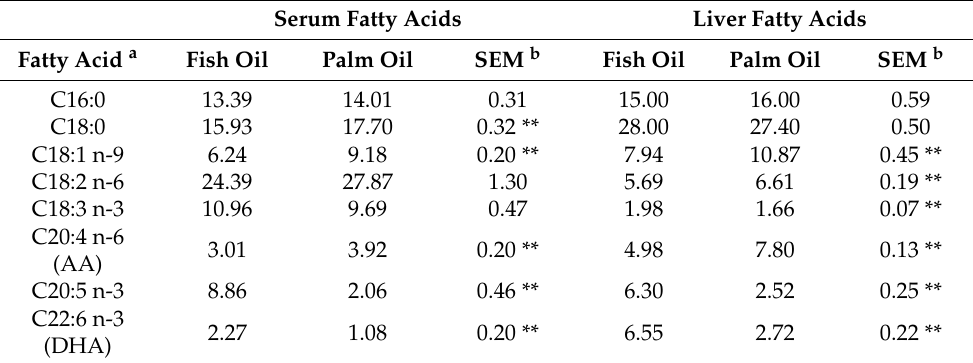
Table 2. Concentrations (mg fatty acid/100 mg of total fatty acids) of the total fatty acids of the sera and livers of the cattle that were group-fed forage with supplemental dried molasses lick tubs that contained 30% (by weight) calcium salts of either fish oil or palm oil fatty acids. Serum Fatty Acids Liver Fatty Acids